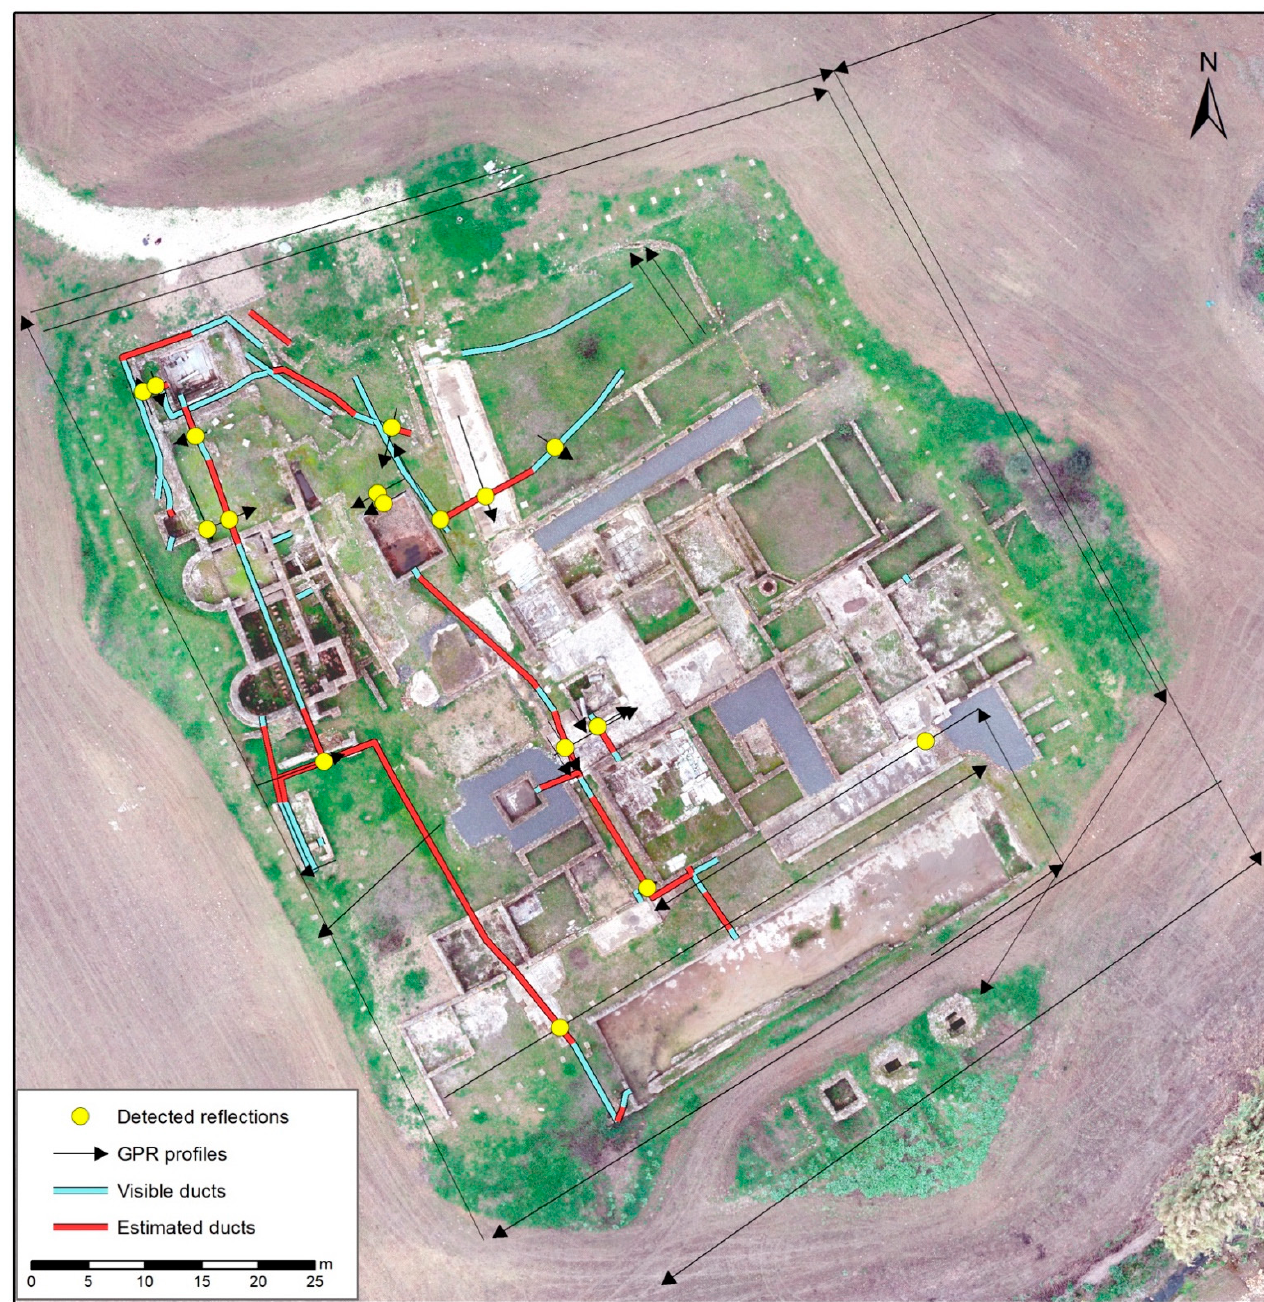
Figure 12. Location of estimated ducts, combining archaeological and GPR information sources.